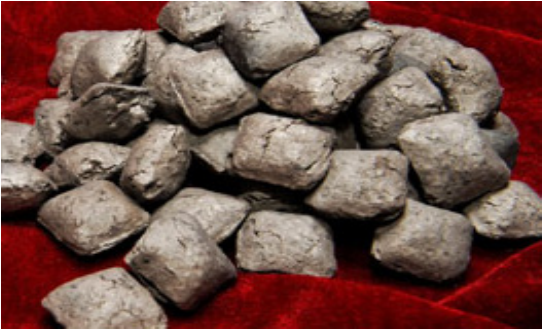
Figure 2. Products of VN alloys.